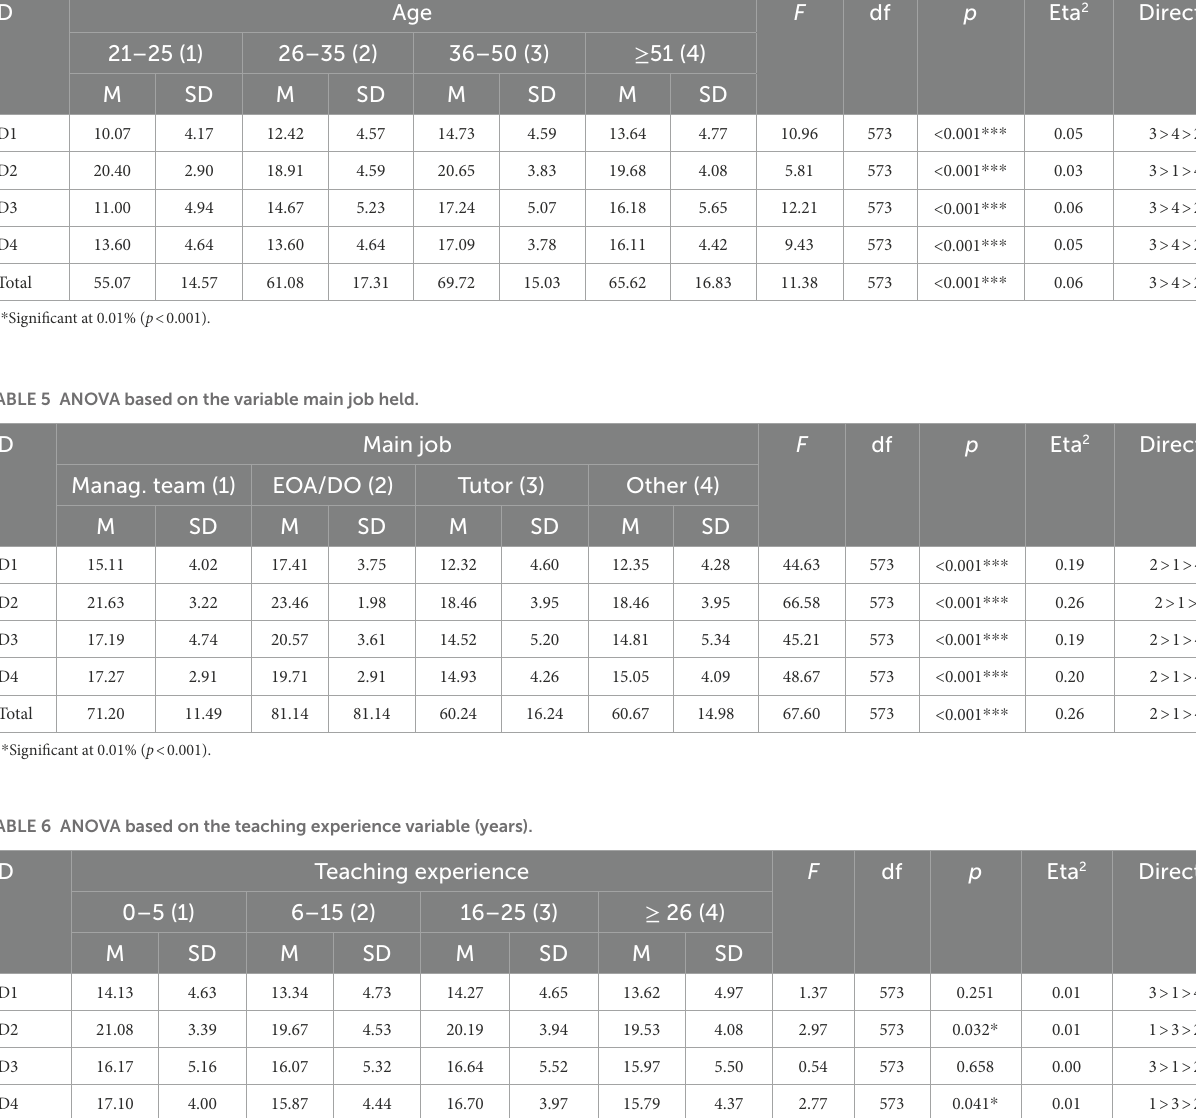
TABLE 4 ANOVA based on the variable teacher age (years). D